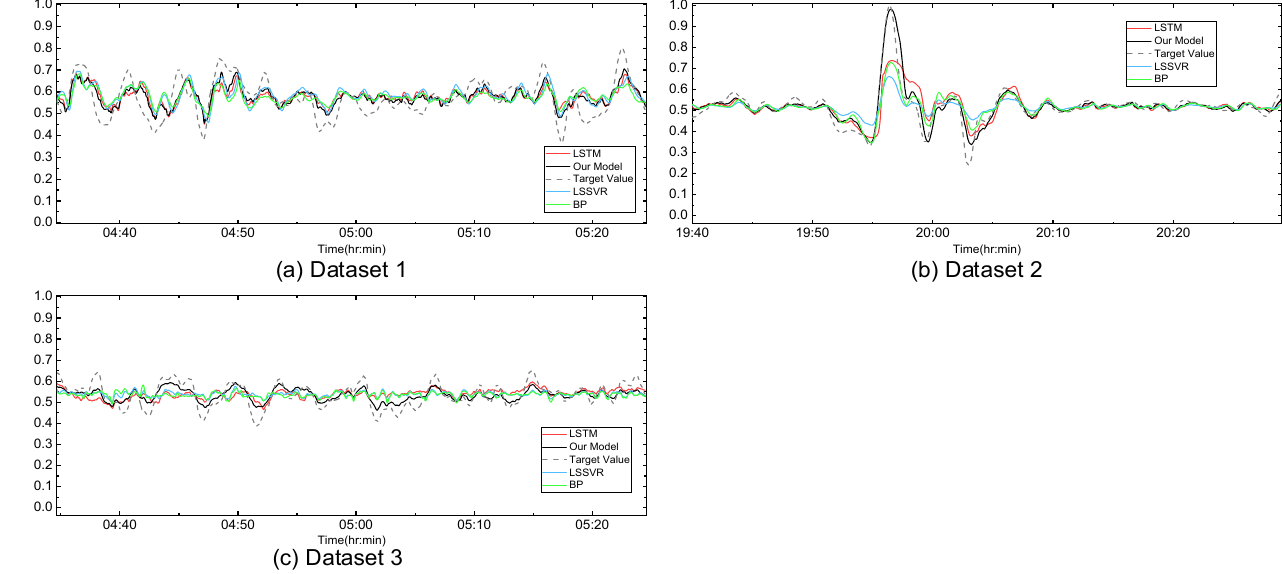
Figure 16. The prediction comparison diagram of bed pressure. Table 10. Comparison results table.